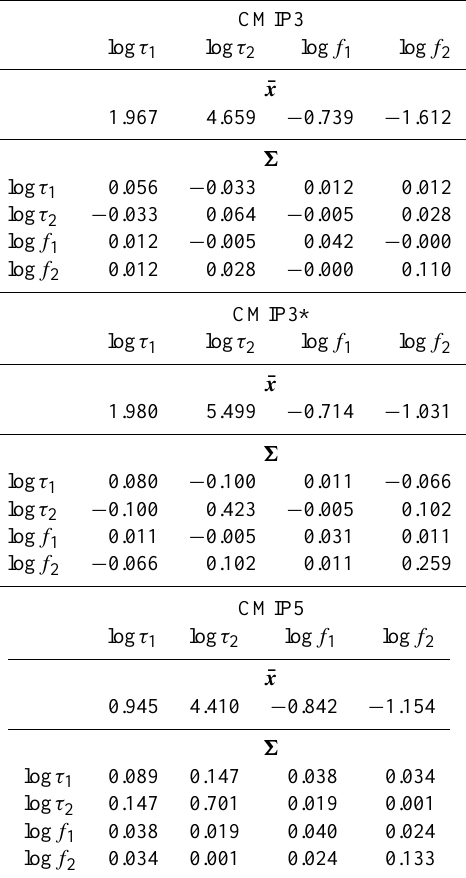
Table 6. Value of mean vector ¯ x and covariance matrix 6 in the IRF T distributions (see Eq. 16) derived using CMIP3, CMIP3*, and CMIP5 data. The distribution is for the logarithm of the parameters in IRF T